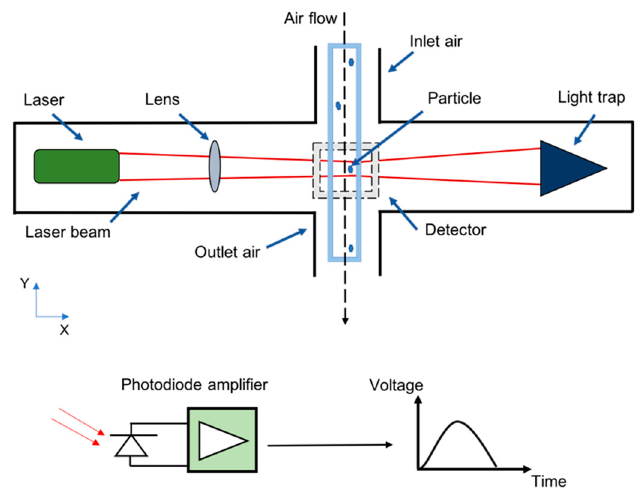
Figure 3. General structure of the optical particle counter.